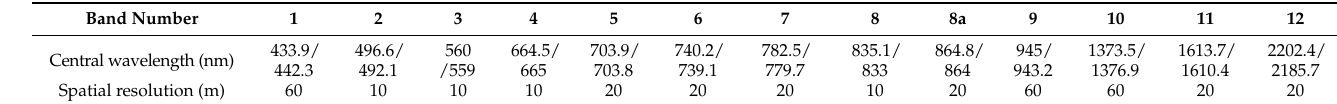
Table 1. Sentinel 2A/B remote sensing data parameters.